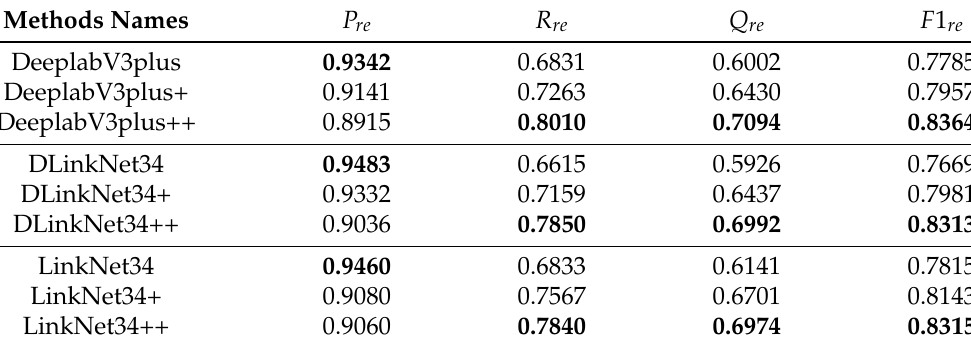
Table 4. Comparative quantitative Evaluation Among Different Methods for Road Extraction on our dataset. With the best results marked in bold. α = 1, β =